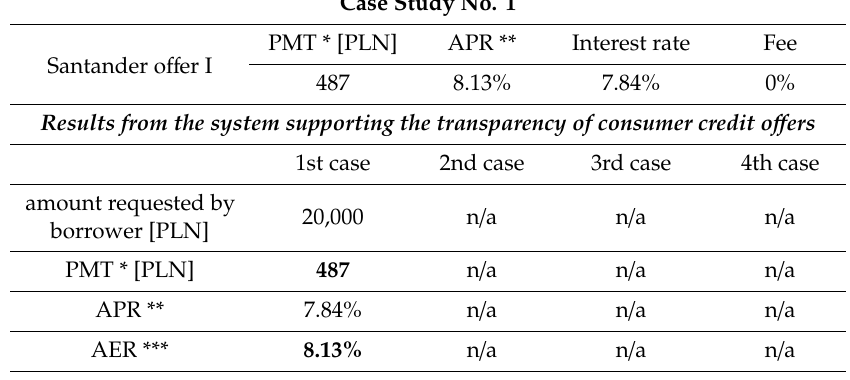
Table 3. Comparison and discussion of consumer credit offers and the results regarding these offers from the system supporting transparency (the amount of credit 20,000 PLN, 48 repayments—PMT constant). Case Study No.